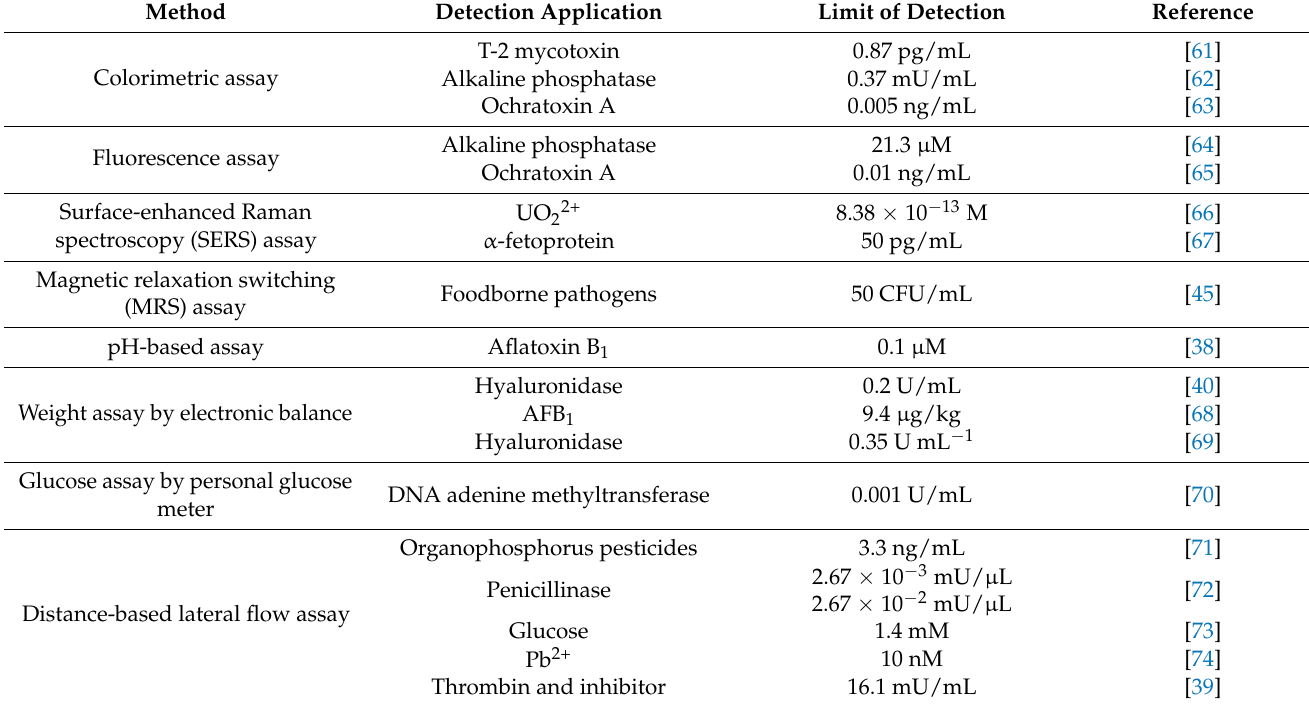
Table 2. The application and limit of detection of sensors with different using